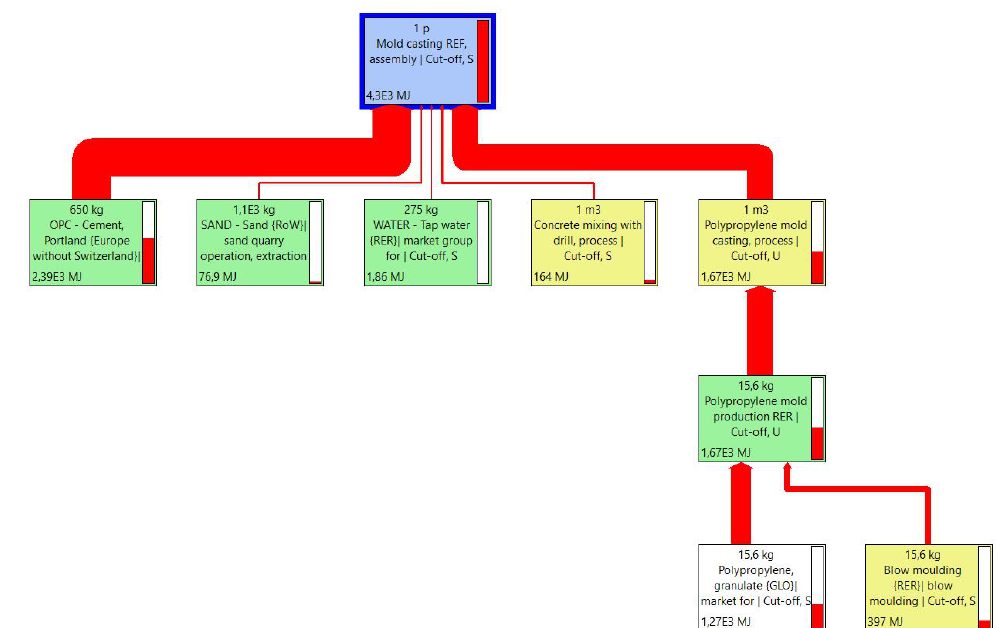
Figure A6. SimaPro CED network for c-CTR mix processing.